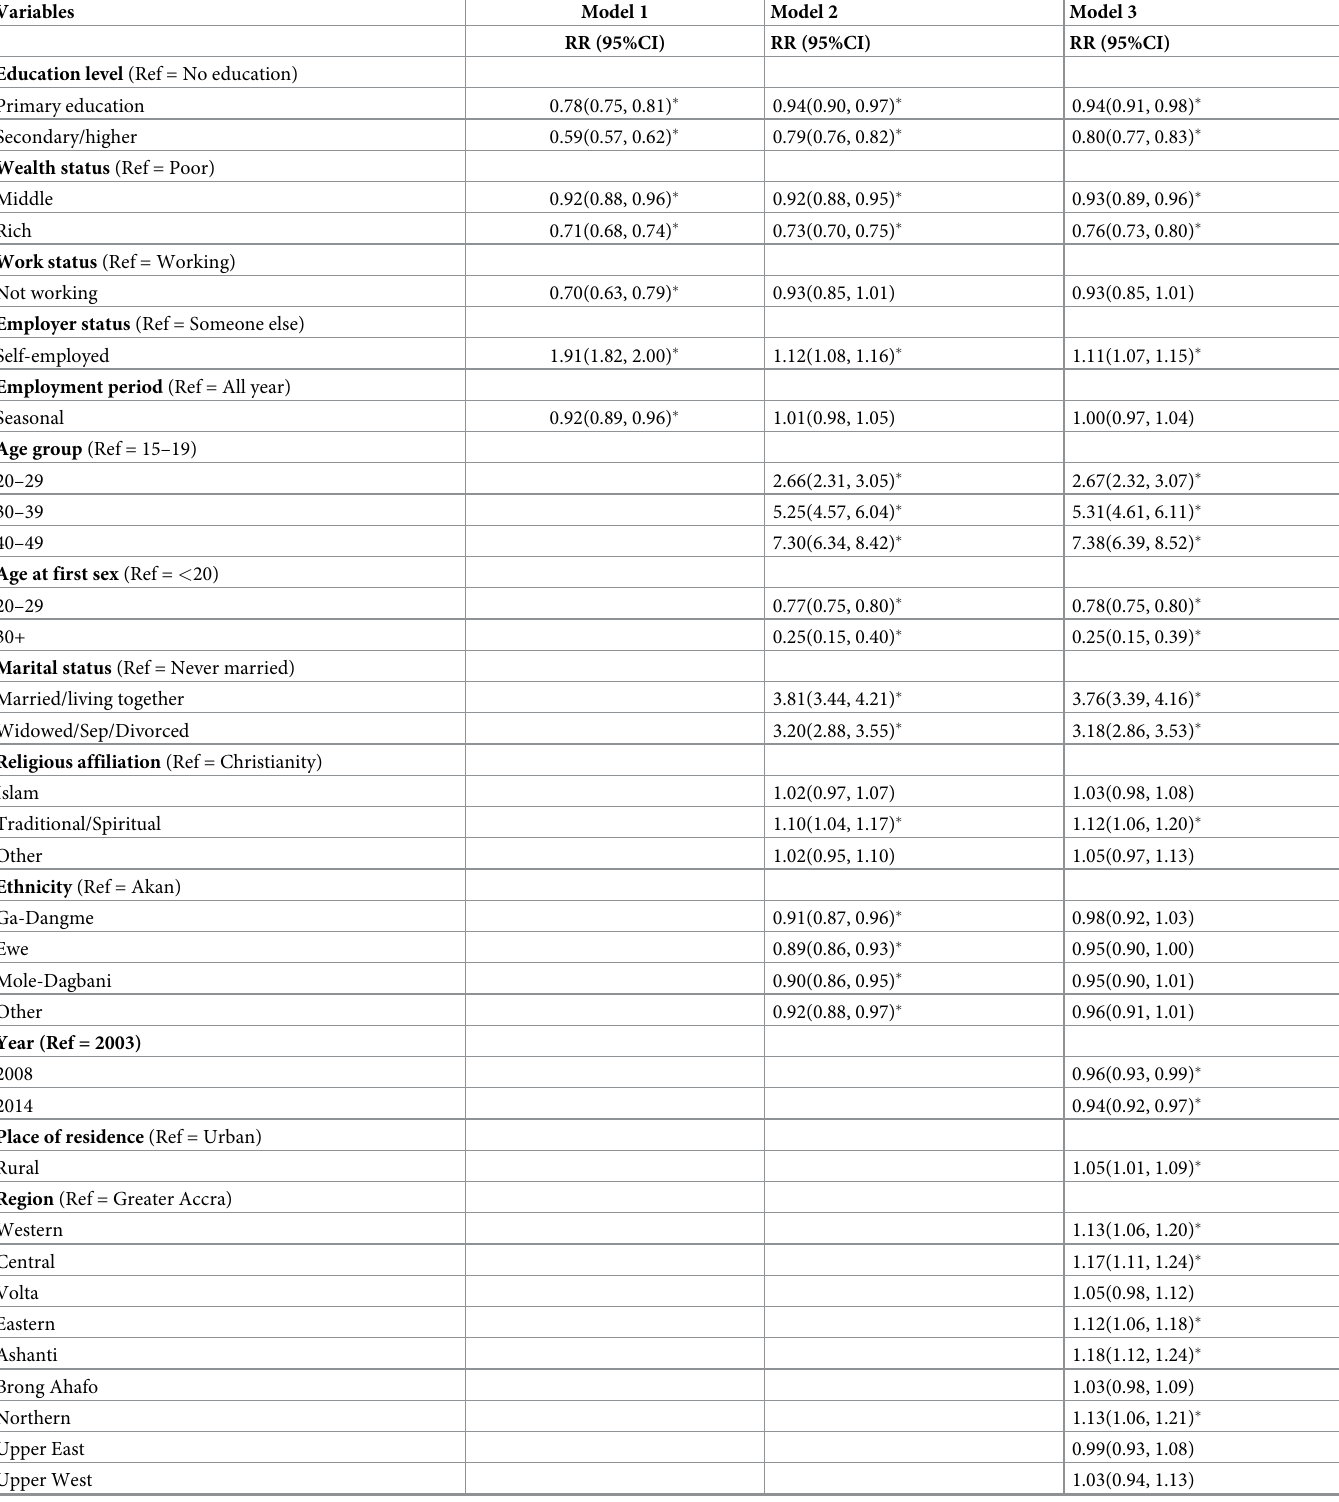
Table 2. Negative binomial regression analysis of cumulative fertility in